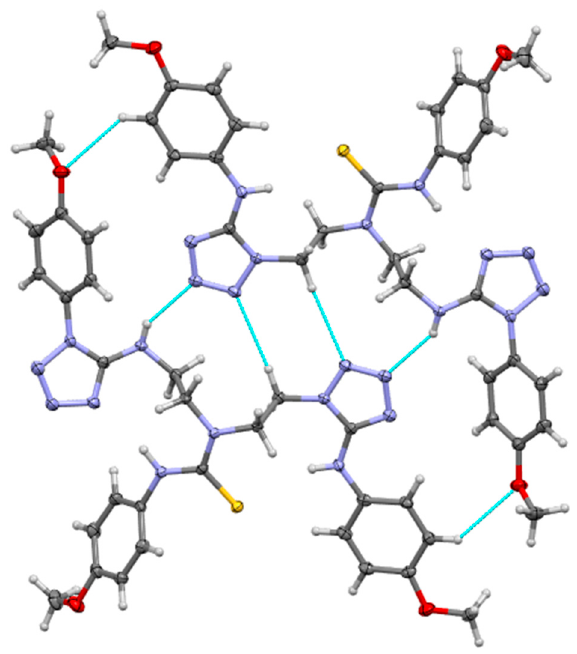
Figure 5. Selected interactions in the crystal lattice of 3-(4-methoxyphenyl)-1,1-bis(2-{[1-(4- methoxyphenyl)-1H-tetrazol-5-yl]amino}ethyl)thiourea ( 7 ).